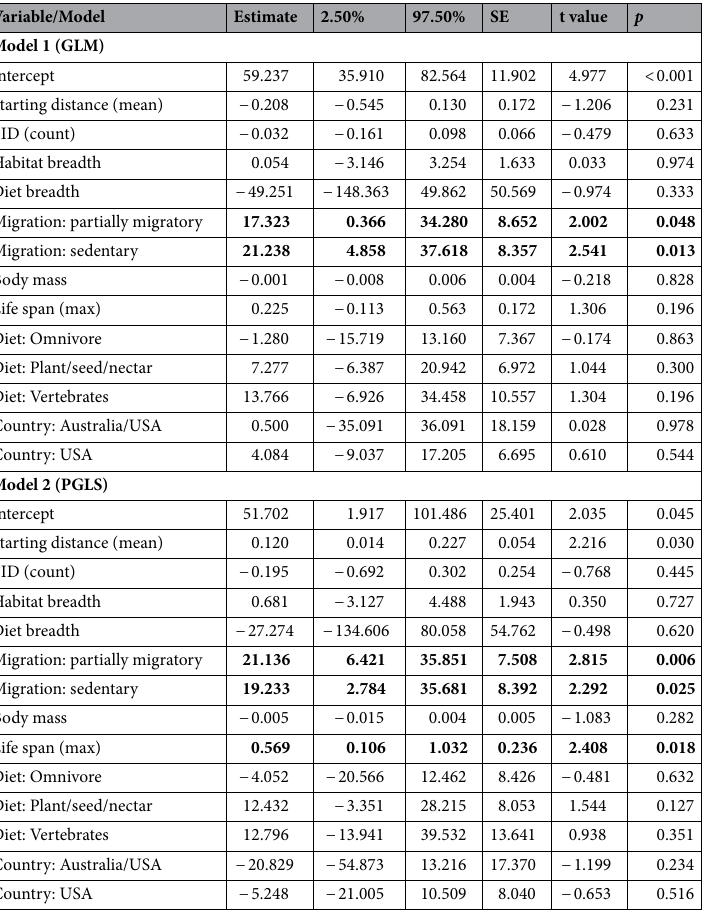
Table 2. Results of models explaining plasticity in escape behaviour in birds as a function of starting distance, the number of observations (FID count), habitat and diet breadth, migratory behaviour (migratory, partially migratory and sedentary birds), body mass, life span and diet type of species, considering also the country where data were collected. The model 1 is a generalized linear model while the model 2 is a phylogenetic generalized least squares model (PGLS) incorporating a phylogenetic correlation term among bird species. Models are based on 3714 observations of FID collected in USA (1240 records), Australia (2359 records) and both (115 records) for 95 bird species. The table shows the values of estimates, the lower (2.5%) and upper (97.5%) limits of confidence intervals, standard error (SE), t and p values. Significant variables are